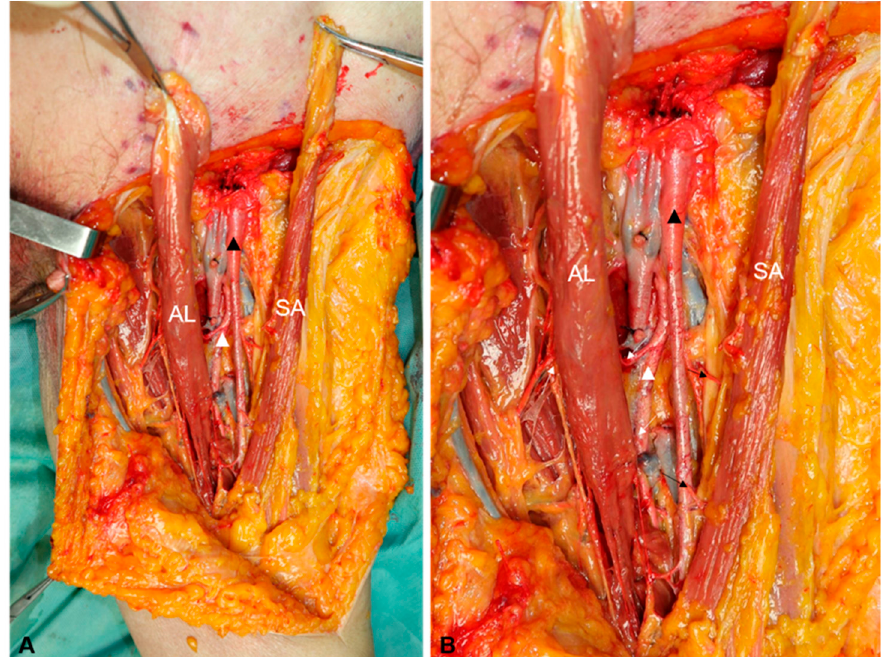
Figure 3. Photos showing two flaps after harvesting ( A ), photos of partial enlargement ( B ) (AL; adductor longus, SA: sartorius, black triangle: femoral artery, white triangle: femoral profound artery, black arrow: muscular perforators of SA). After the two procedures, the two muscle flaps were cut for volume measurement by taking the horizontal line of the rotation point of sartorius muscle flap.